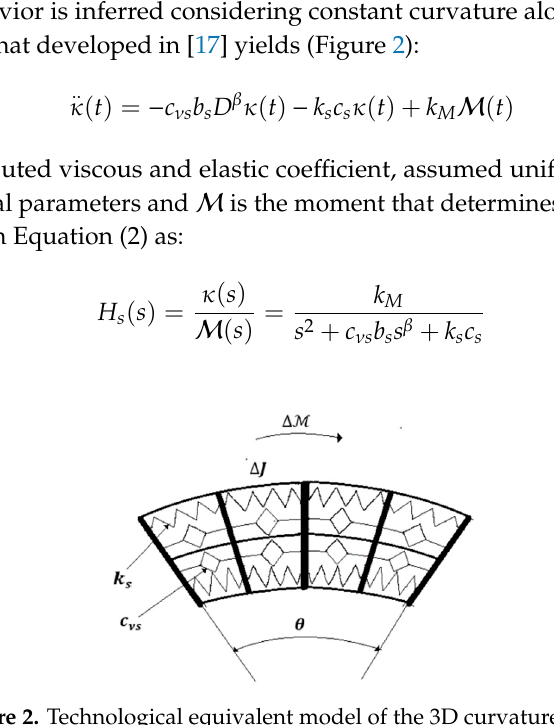
Figure 3. IHRG Figure 3. IHRG system.